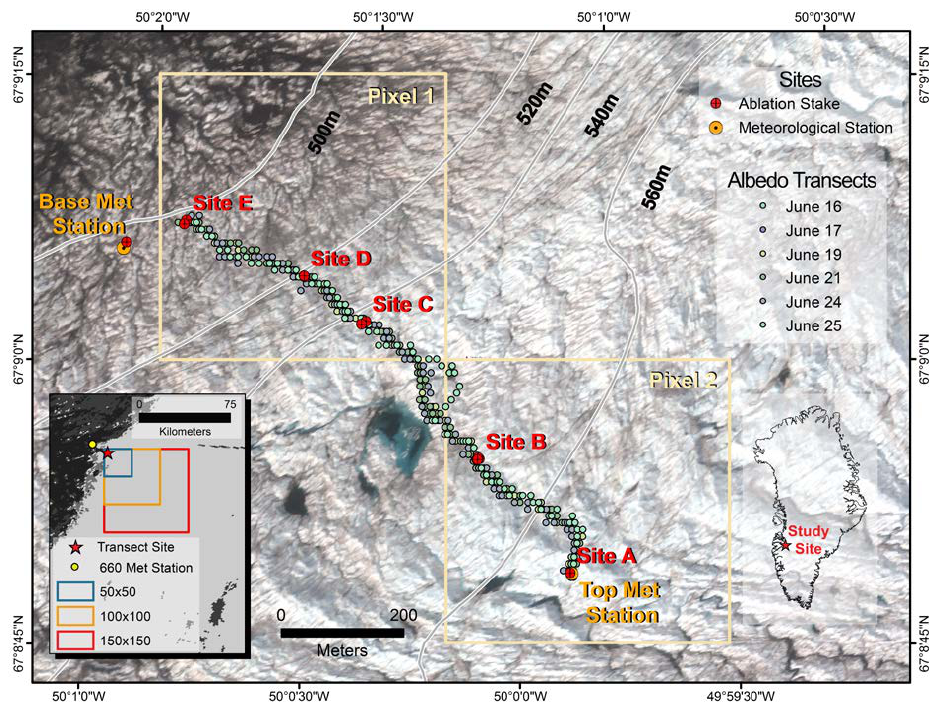
Figure 1. 23 June 2013 WorldView-2 true color image (bands 5, 3, and 2 RGB) of the study site with elevation contours (m), MODIS pixel extents (yellow boxes), and location of the six albedo transects, ablation stake, and meteorological station sites. Location of three MODIS spatial extent regions overlaid on a 31 May 2013 MOD10A1 image (black box